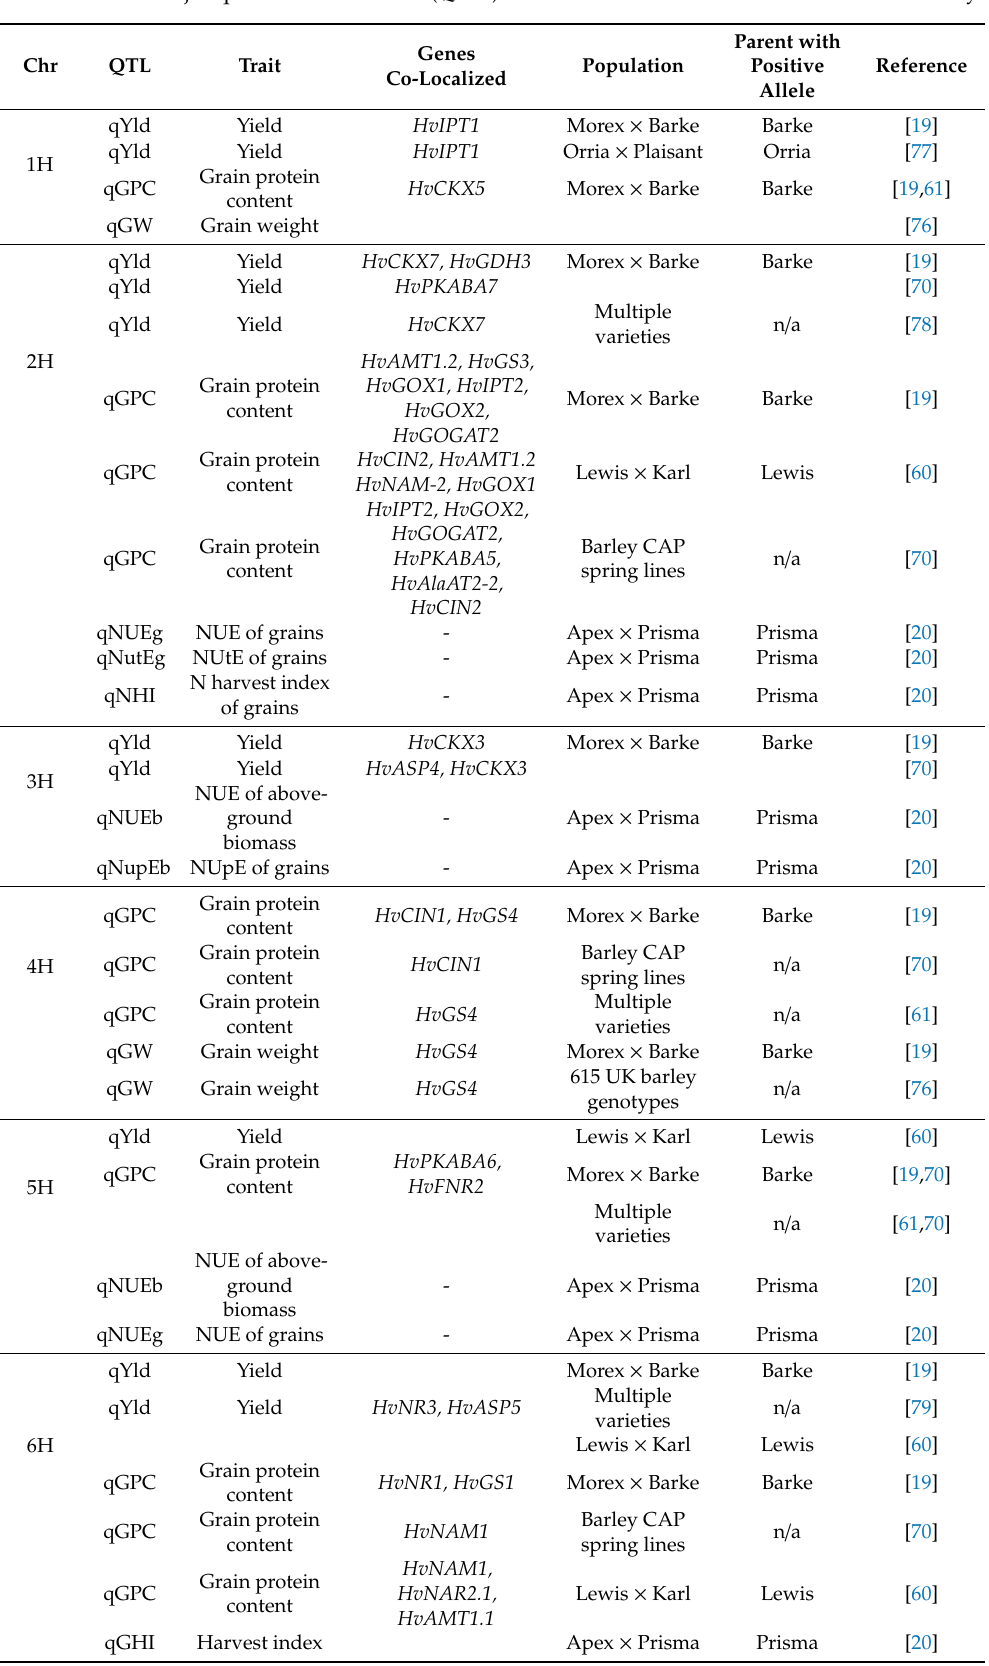
Table 2. List of major quantitative trait loci (QTLs) related to NUE and NUE-related traits in